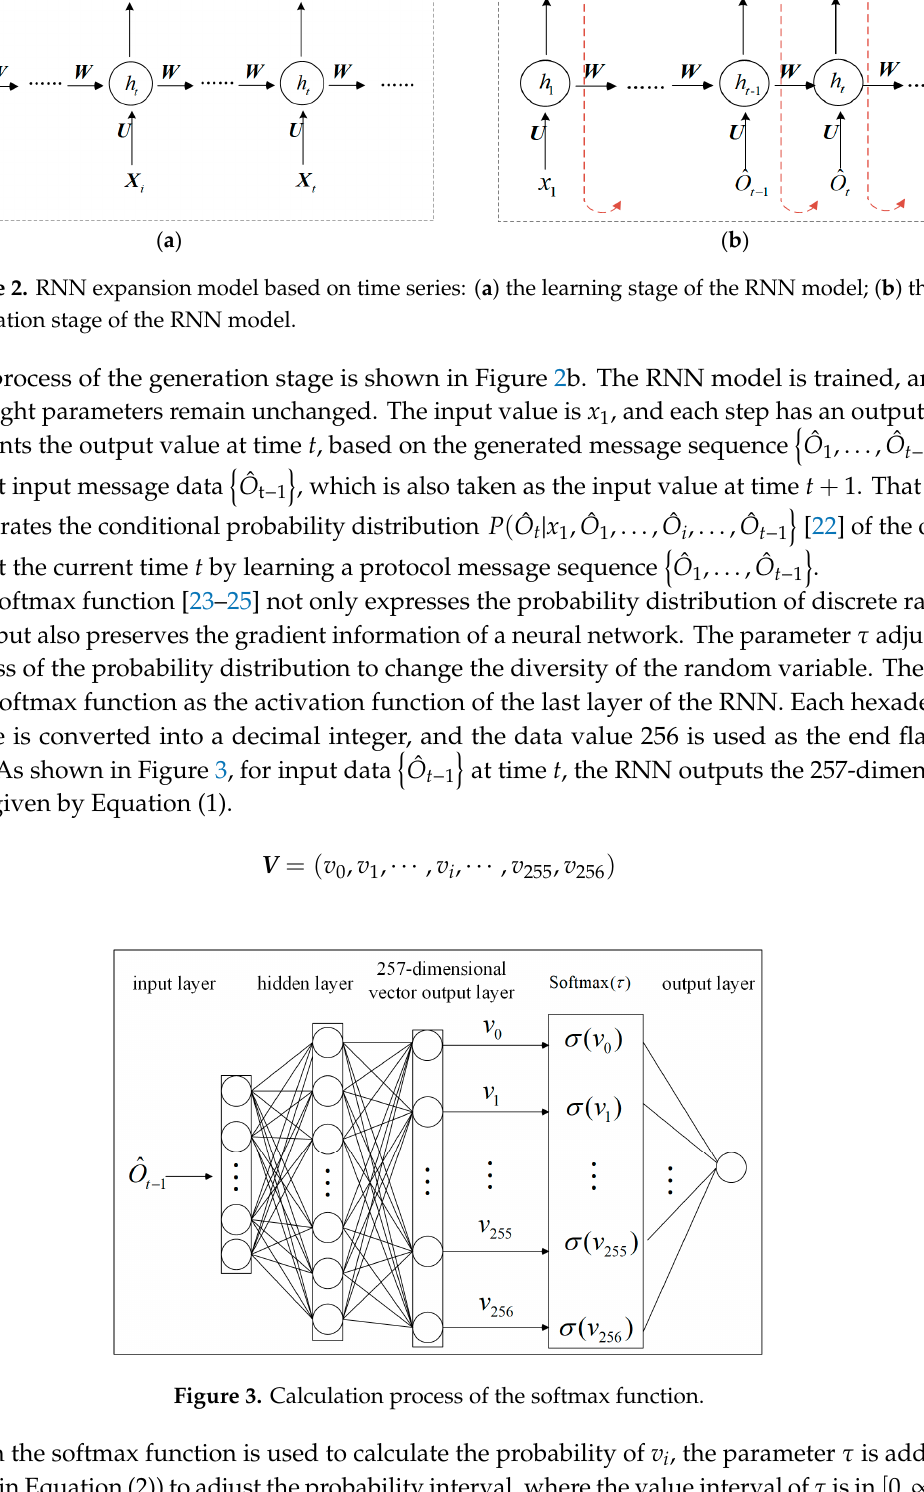
Figure 3. Calculation process of the softmax function.